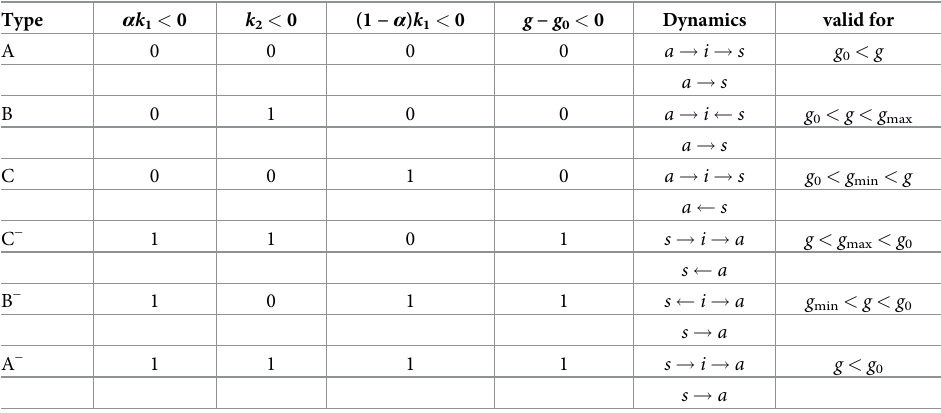
Table 1. Development types of the DST model, Eqs